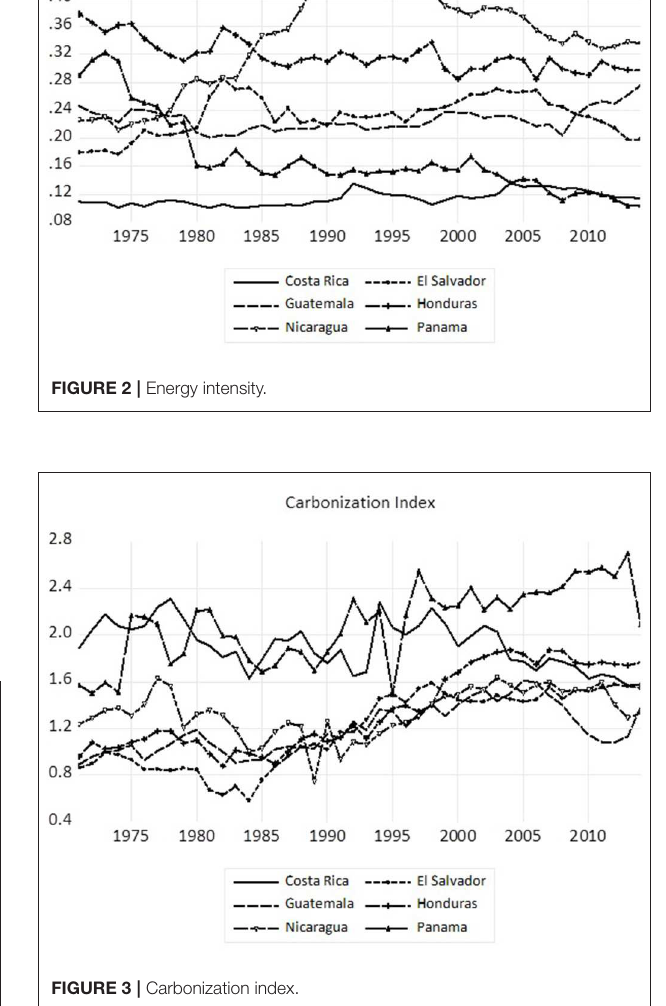
FIGURE 3 | Carbonization